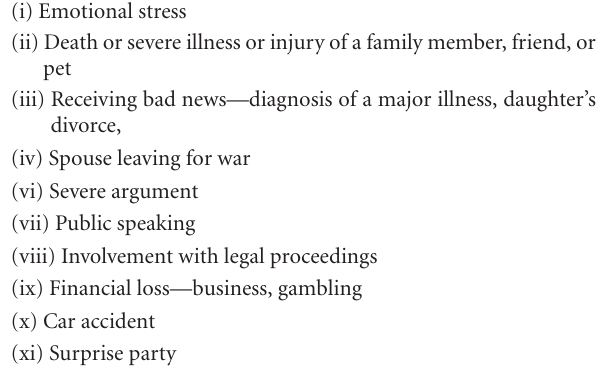
Table 1: Stressors reported to trigger TTC [6].